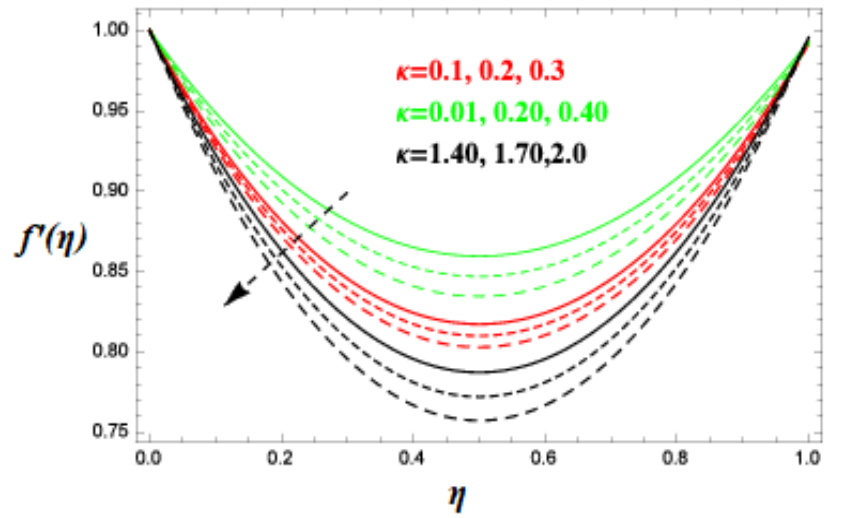
Figure 3. Variations in velocity field 𝑓(𝜂) for different values of 𝜅 .